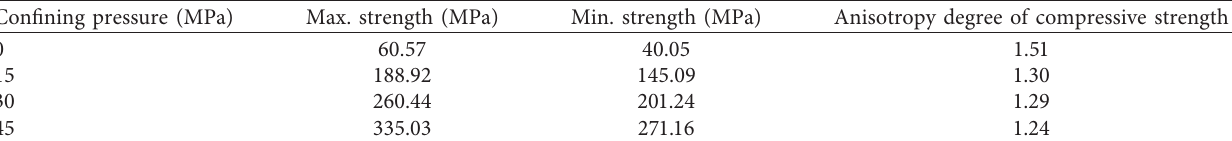
Table 5: Triaxial compression strength anisotropy of tight sandstone